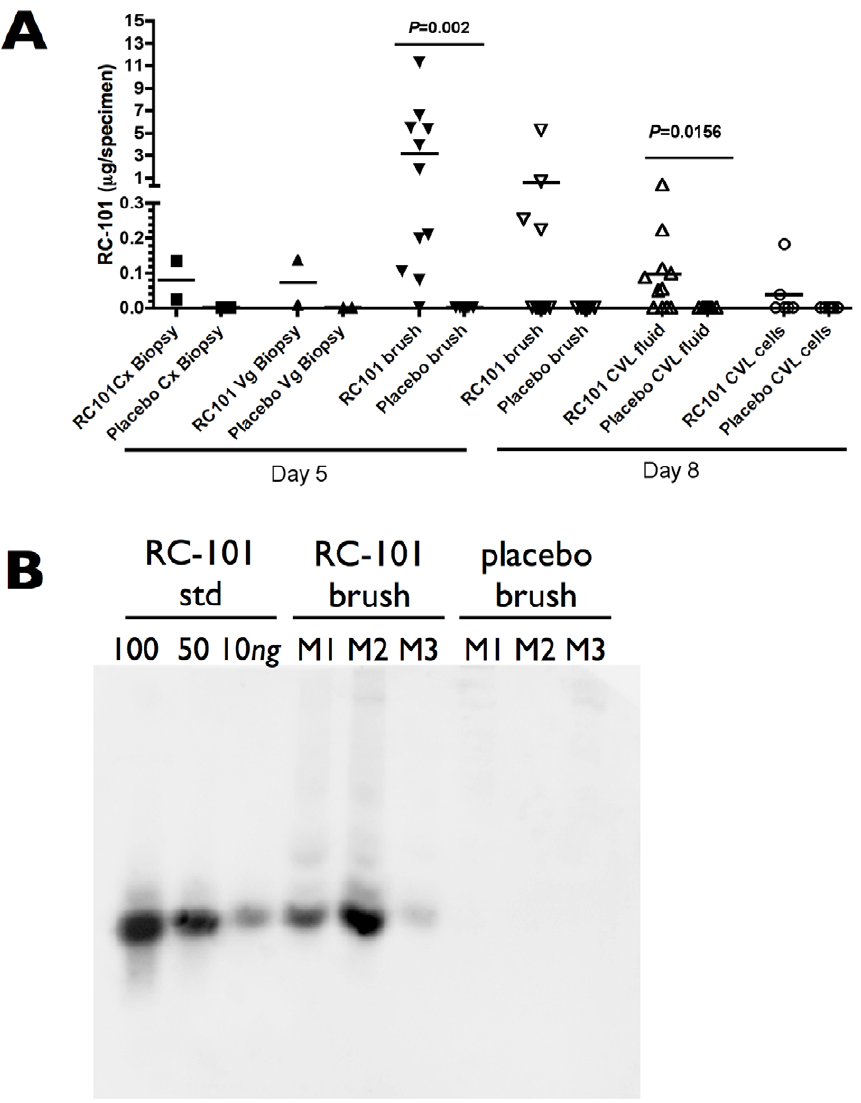
Figure 5. RC-101 was retained in the cervicovagina up to four days post-application. RC-101 was assessed by quantitative western blot from acetic acid-extracted samples of cervical biopsies, vaginal biopsies and cytobrushes at day 5, and cytobrushes and CVL fluid at day 8 ( A ). Note that CVL fluid was subdivided into both the cellular portion and the fluid portion. A representative western blot for RC-101 in cytobrushes at day 5 is shown in ( B ), with ‘‘M1’’, ‘‘M2’’, and ‘‘M3’’ signifying three individual monkeys. Note that the same monkey received both RC-101 films and placebo films six weeks apart, and that RC-101 was absent in cytobrushes obtained from monkeys that received placebo films. The P -values presented were adjusted for multiple comparisons using Tukey